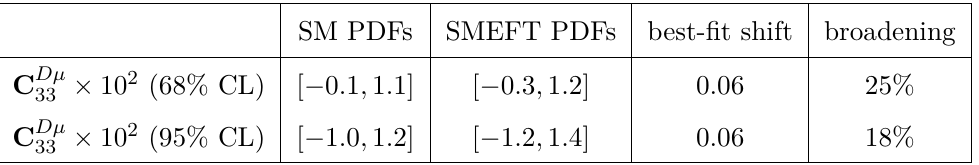
parameter from EFT benchmark scenario II. 33